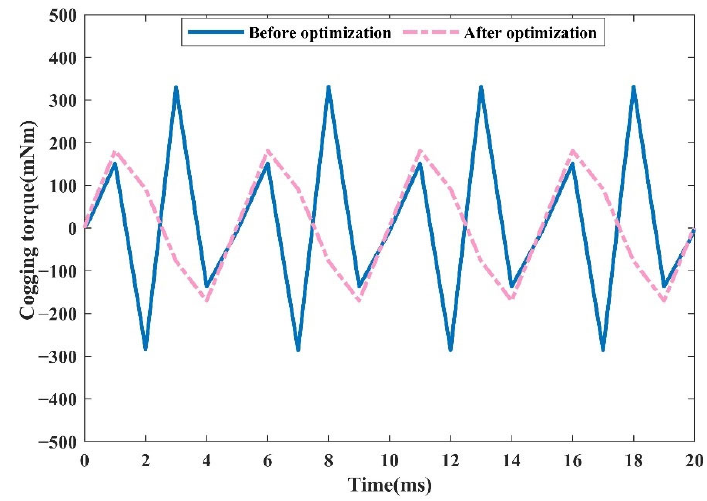
Figure 16. Comparison of cogging torque of motor before and after optimization.